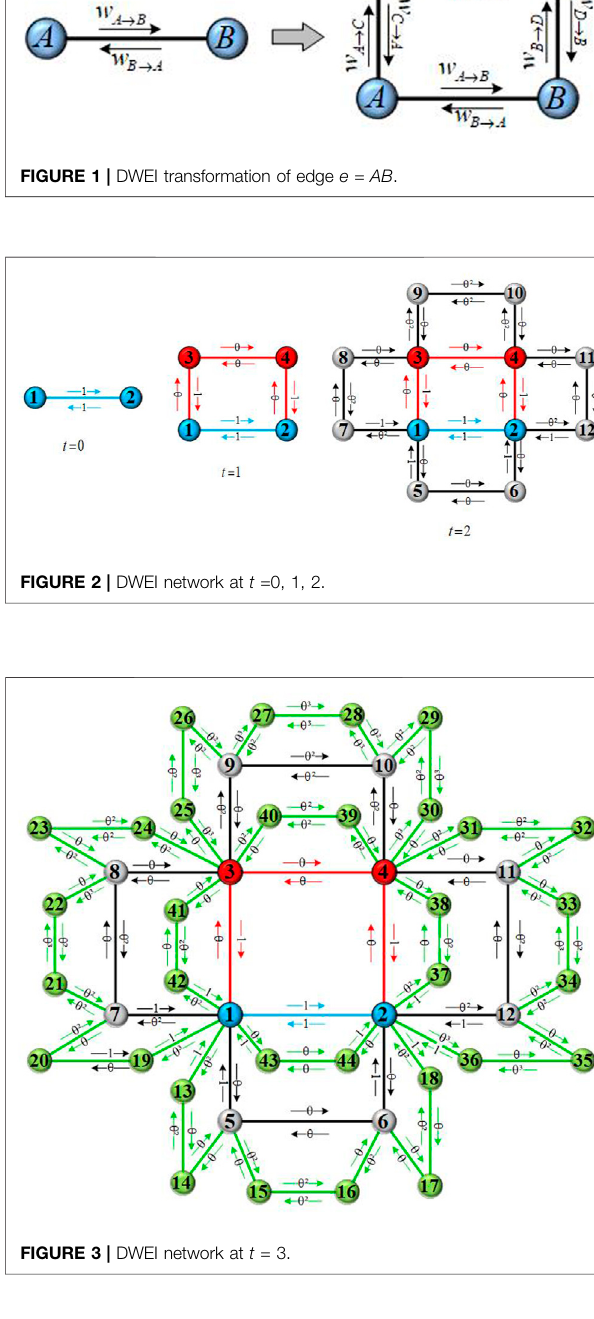
Figure 1 is a schematic diagram of the DWEI-transformation.